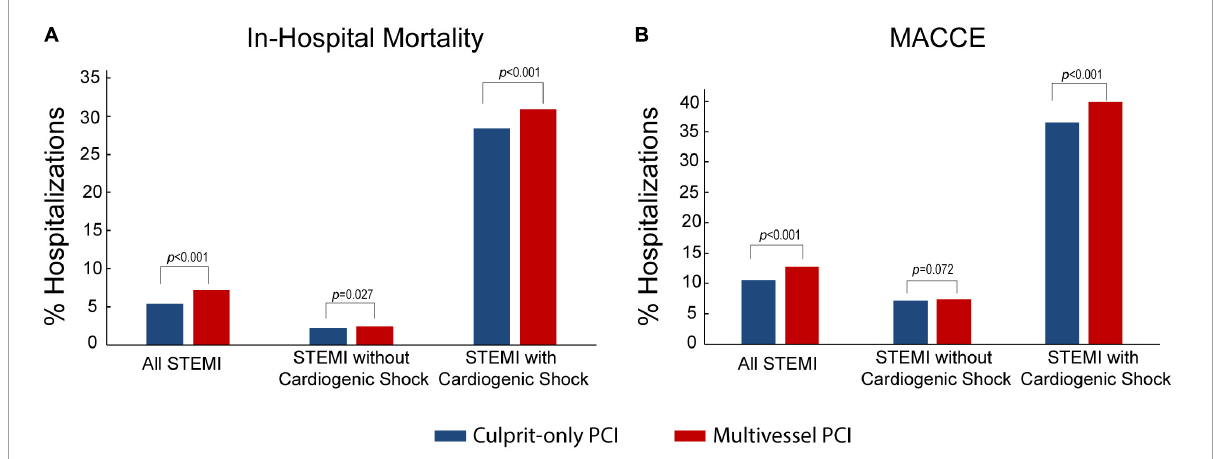
FIGURE2 In-hospital mortality and MACCE in multivessel PCI vs. culprit-only PCI. (A,B) Shown are percentages of in-hospital mortality (A) and MACCE (B) comparing multivessel PCI vs. culprit-only PCI in the overall STEMI cohort, STEMI without cardiogenic shock cohort, and STEMI with cardiogenic shock cohort.